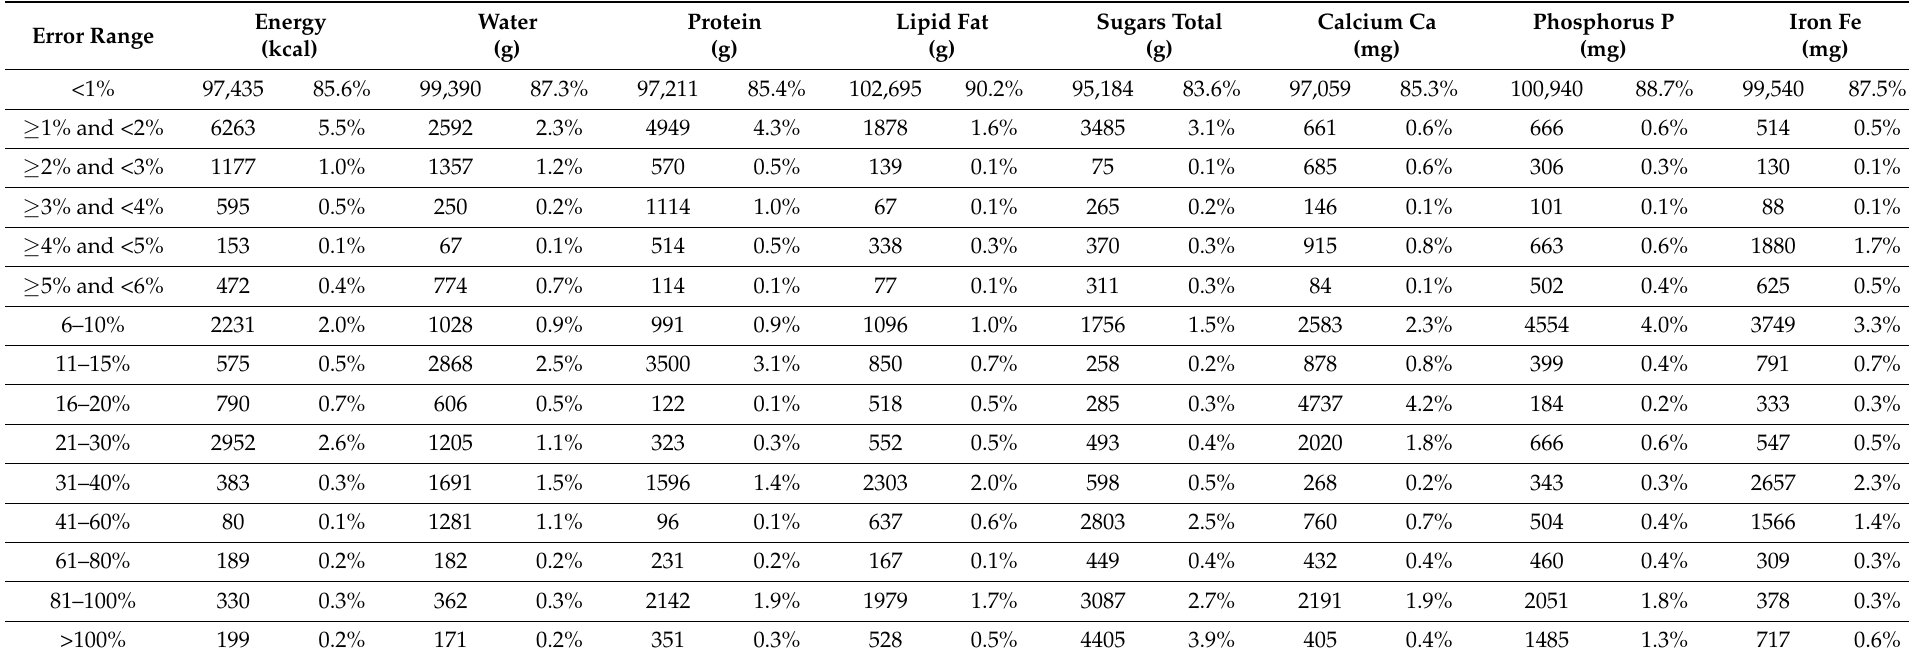
Table 4. Discrepancy comparison table of NNHS analysis with the results of this study in the food_wt_and_nutrients